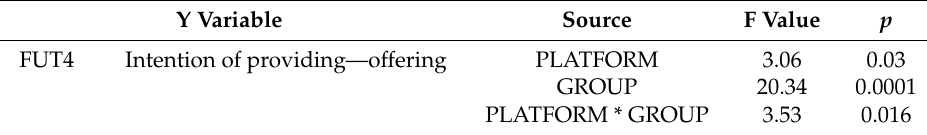
Table 8. Model with FUT4 “Intention/Possibility of being a provider/offering the service”.